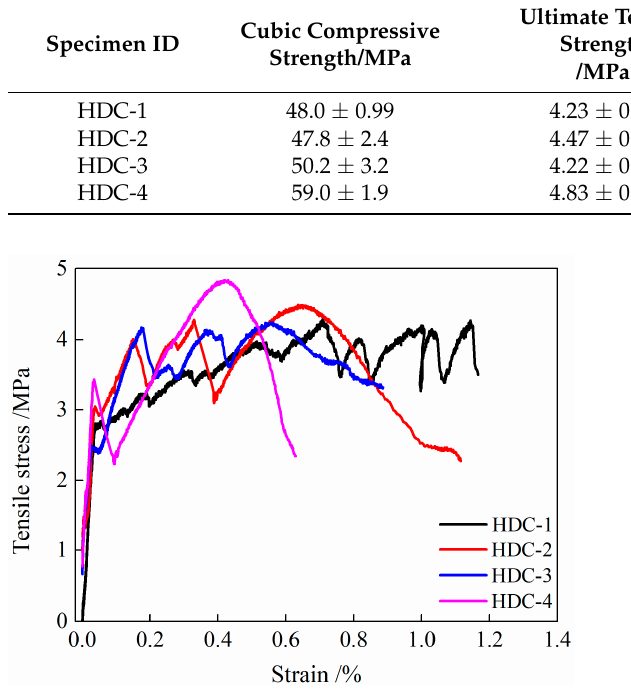
Figure 7. Tensile stress–strain relationship curves of HDC with di ff erent mixtures.